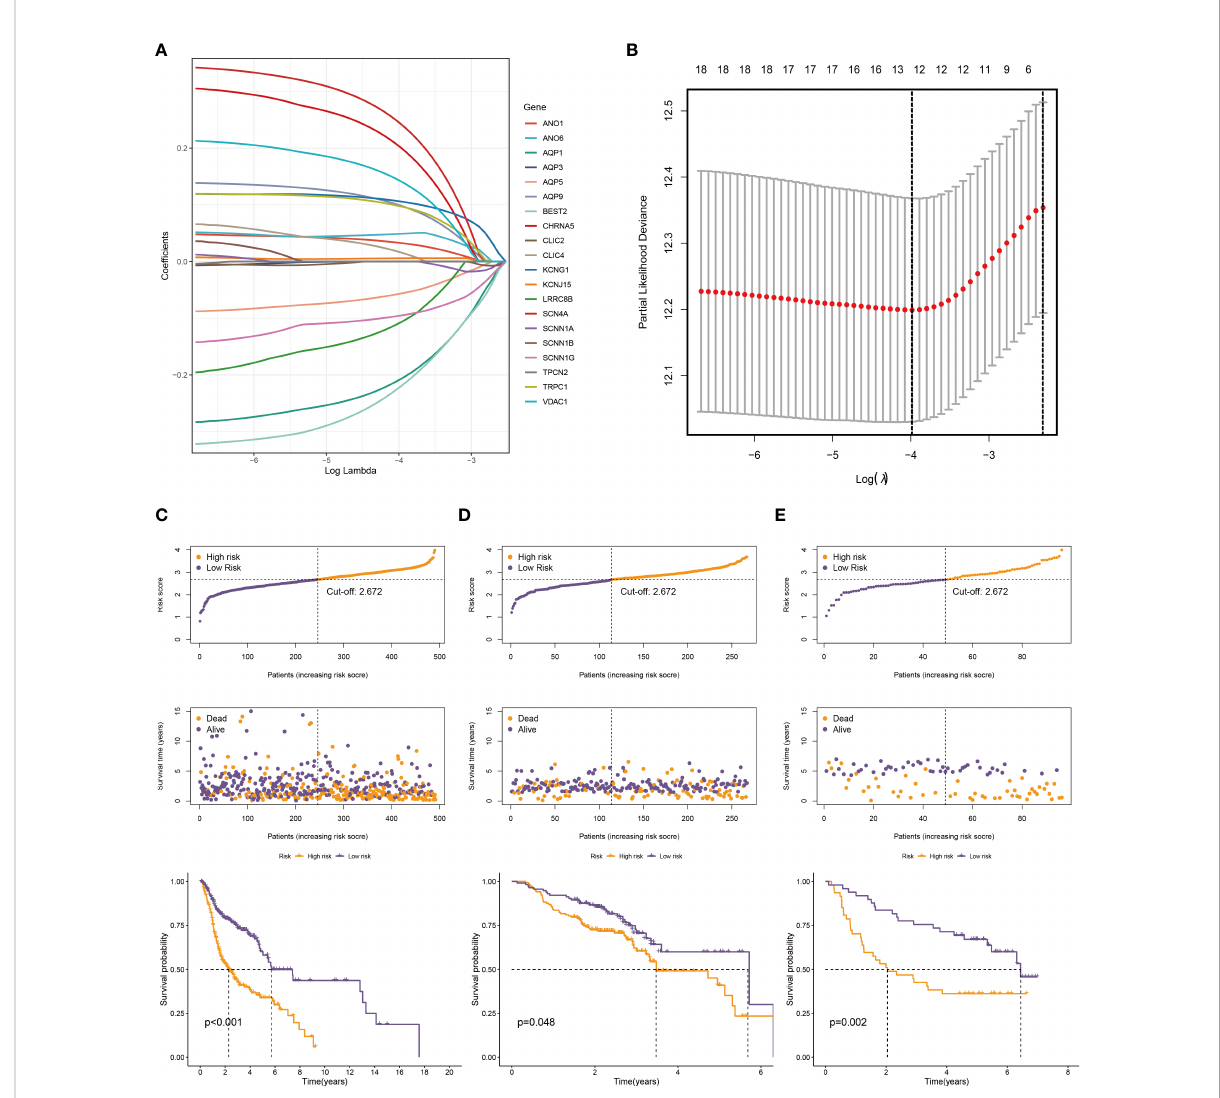
FIGURE 4 Construction of a prognostic model. (A) The LASSO coef fi cient pro fi les of the 20 ion channel genes. (B) Tuning parameter ( l ) selection cross- validation error curve, the optimal log l value is the left dotted line in the plot. The distribution of risk score, overall survival time, and OS status in the TCGA (C) , GSE65858 (D) , and GSE41613 cohorts (E) . The dotted line indicates the median point for risk score used to stratify patients into low-risk and high-risk groups, and the survival time of low-risk patients in the three datasets was